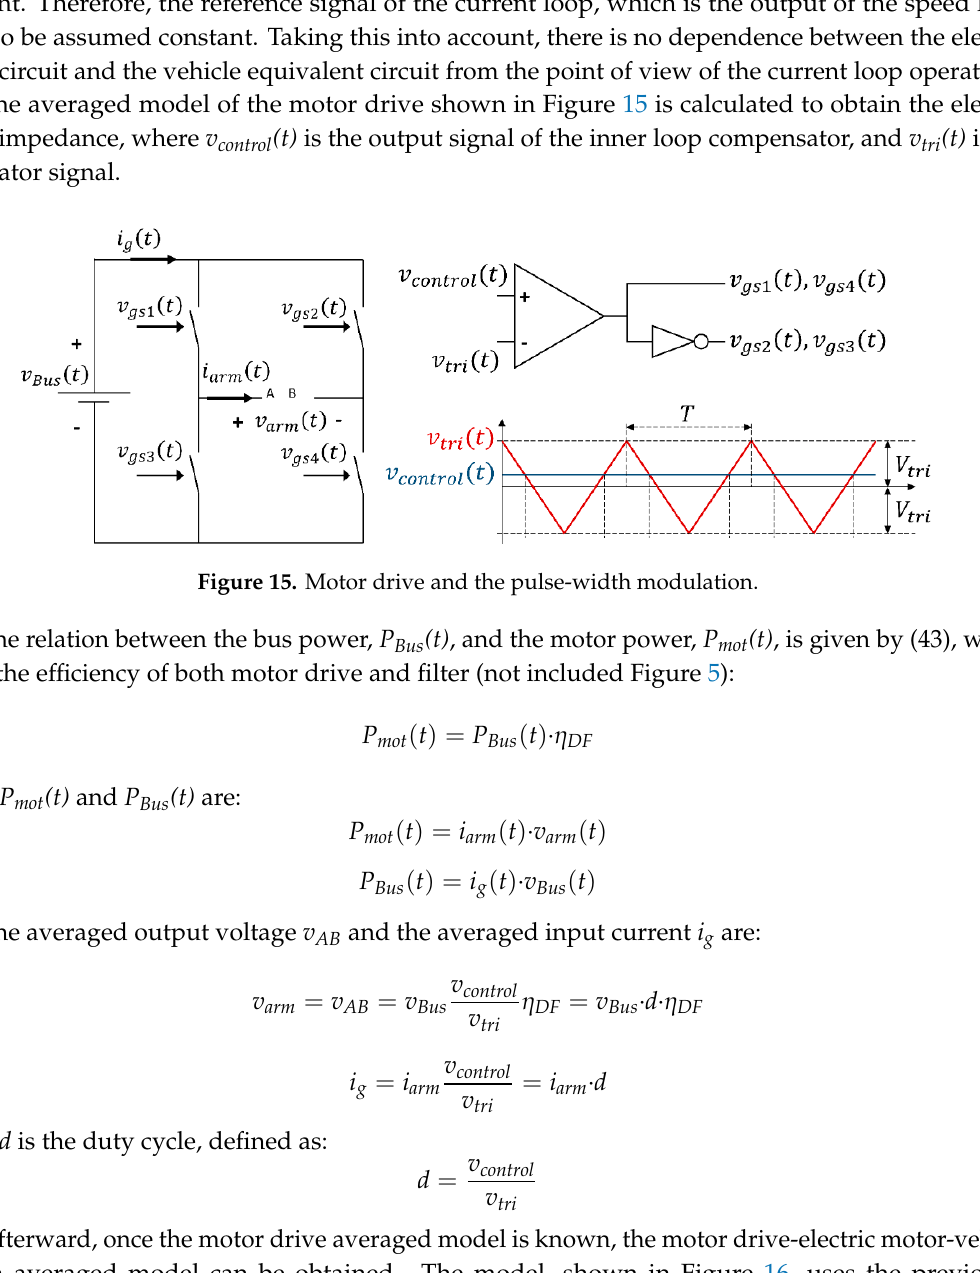
Figure 14. A system composed of the vehicle, electric motor, motor drive, and filter.